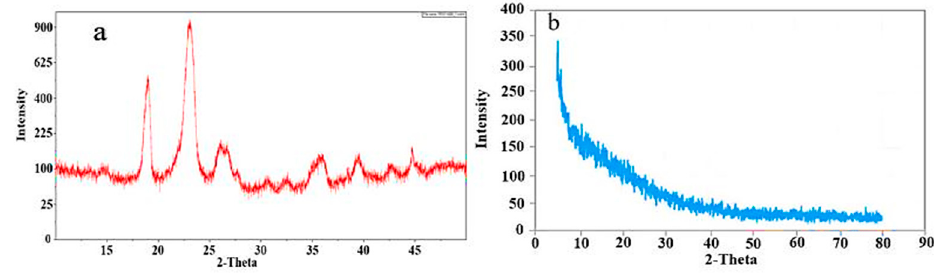
Figure 5. PXRD of ( a ) PEG-8000 and ( b ) formulation.